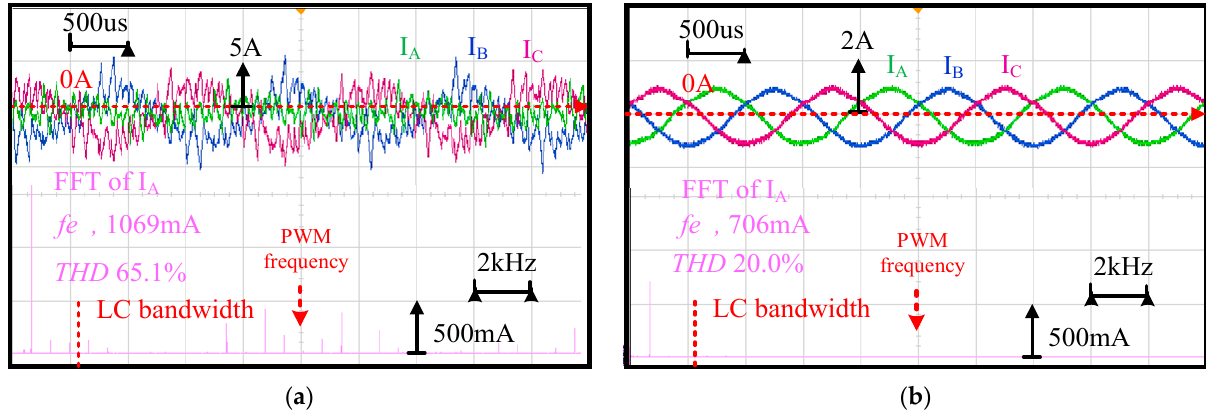
Figure 9. Machine three-phase currents and the corresponding spectrum for the drive ( a ) without and ( b ) with LC filter (40 krpm and fan load).